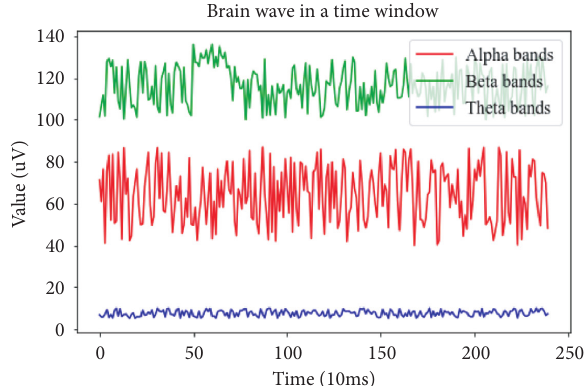
Figure 5: Brain wave during the lane-changing